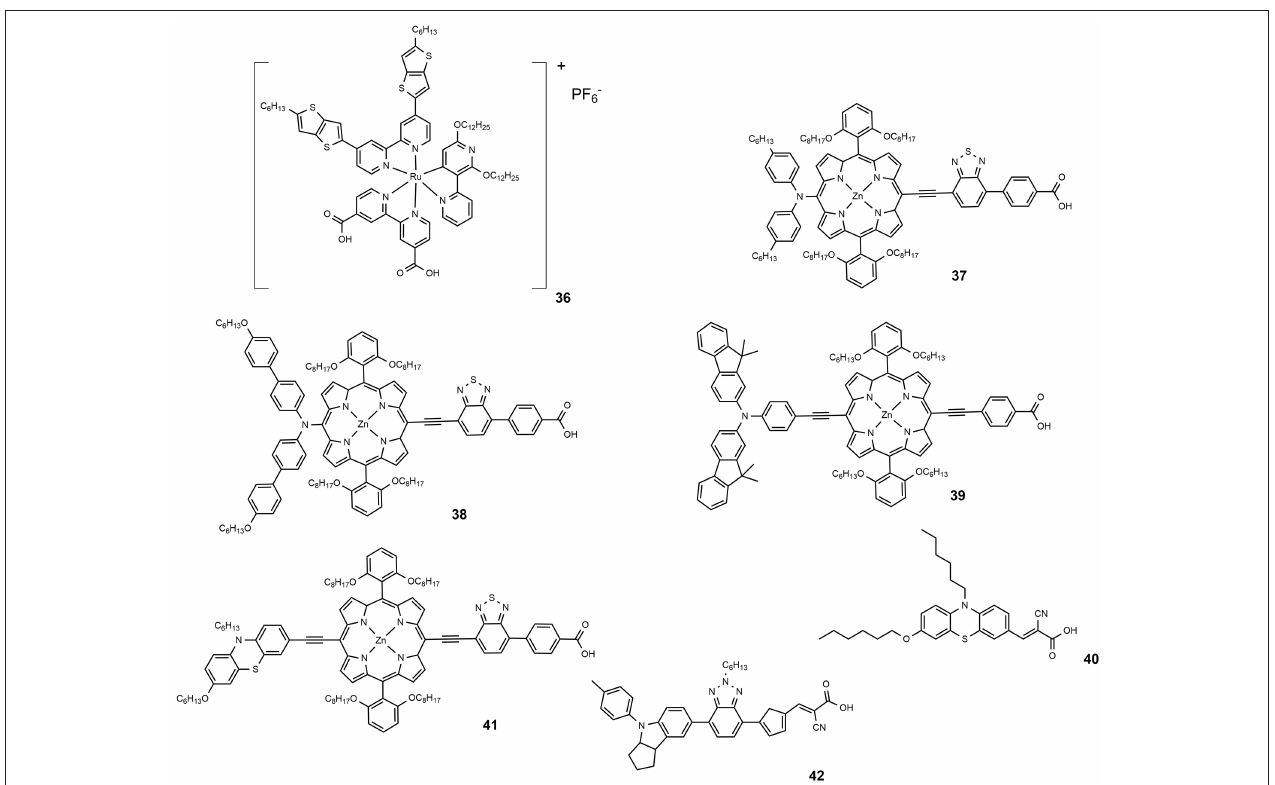
FIGURE 6 | Chemical structures of dyes